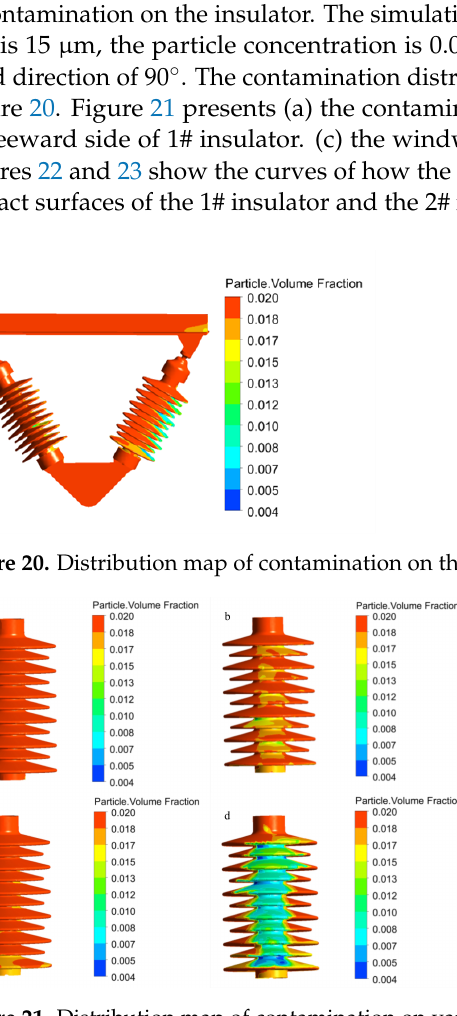
Figure 21. Distribution map of contamination on various sides of the insulator. ( a ) the contamination distributions on the windward side of 1# insulator; ( b )the contamination distributions on the leeward side of 1# insulator; ( c ) the contamination distributions on the windward side of 2# insulator; ( d ) the contamination distributions on the leeward side of 2#